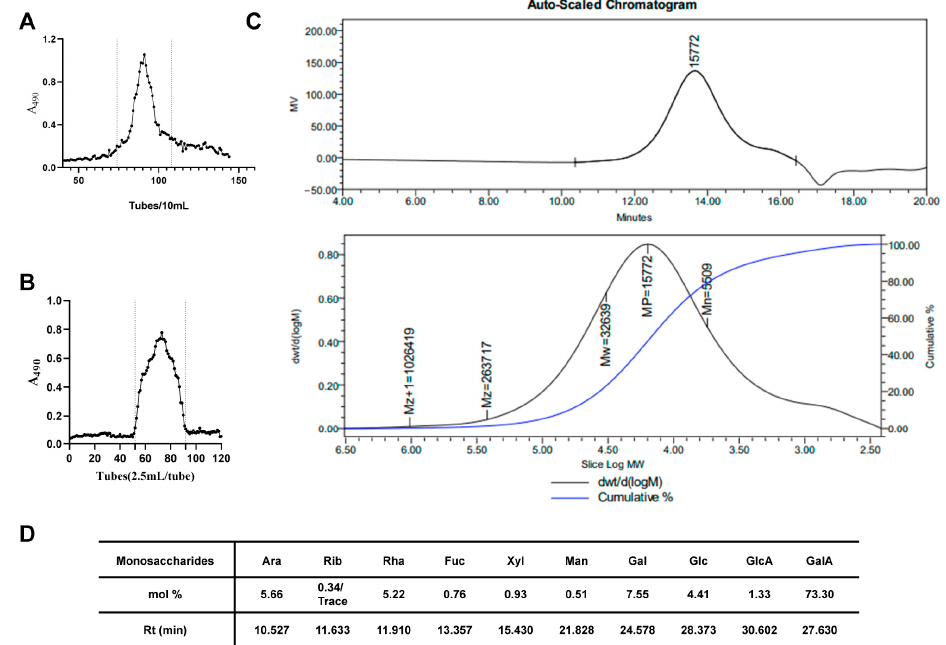
Figure 1. Isolation and characterization of SMRR polysaccharide. ( A ) The elution profile of crude SMRR polysaccharide on DEAE agarose gel FF (NaCl as eluent). A single fraction was obtained. ( B ) The elution profile of SMRR purification on Sepharose 6FF and SMRR was obtained. ( C ) The molecular weight determination of SMRR polysaccharide by gel permeation chromatography. ( D ) The monosaccharide composition of SMRR polysaccharide (mol %).